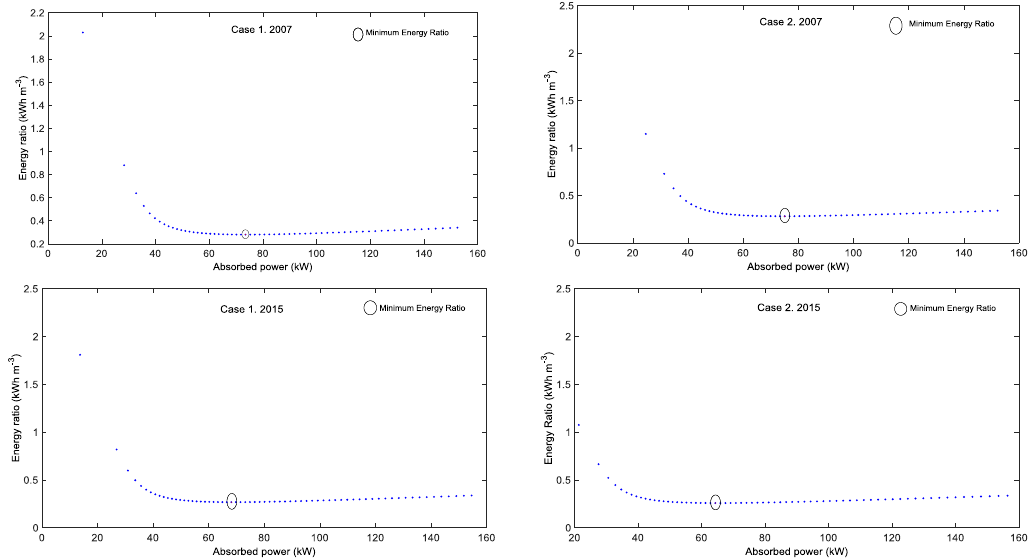
Figure 10. Energy ratio (kWh m −3 ) at each variable speed ratio ( α ) in WUA B.